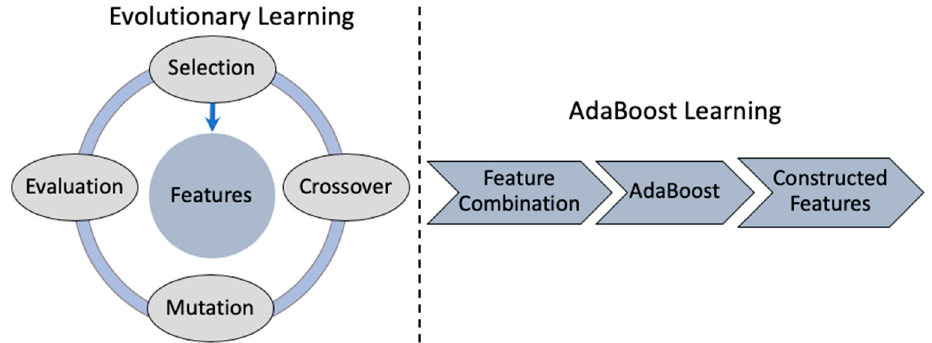
Figure 1. Overview of the training procedure of the algorithm.